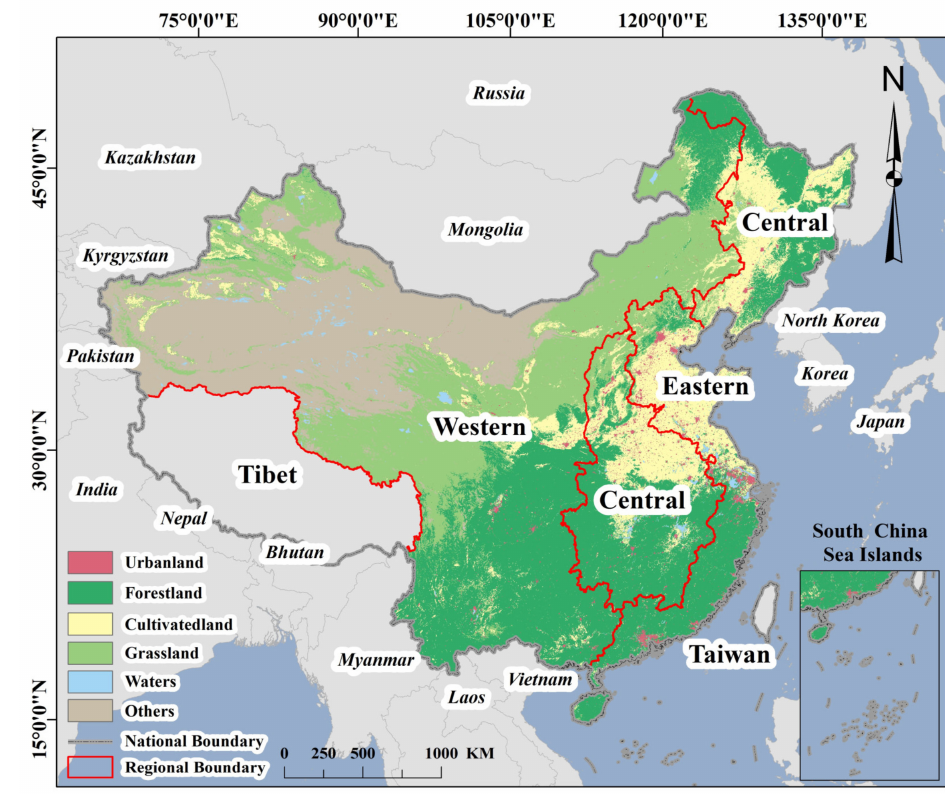
Figure 2. Regional division.